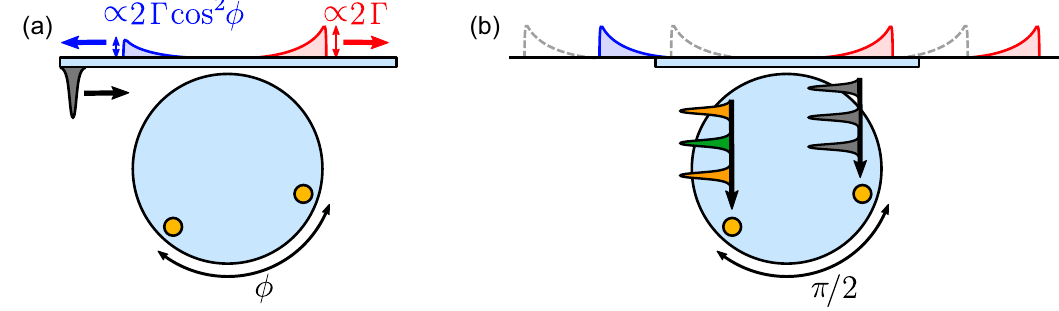
FIG. 4. Manipulating the single-photon emission of a pair of emitters. (a) Weakly exciting the emitters with a resonant pulse (gray) through the CW mode will prepare the system in the superposition ð e i ϕ j eg i þ j ge iÞ = (b) By independently controlling the excitation phase (via free-space excitation) of the two emitters positioned such that ϕ ¼ π = 2 , the microresonator incorporates the functionality of a single-photon router. The phase of the free-space excitation pulse is represented by the color, where green, gray, and orange correspond to π = 2 , 0, and − π = 2 ,